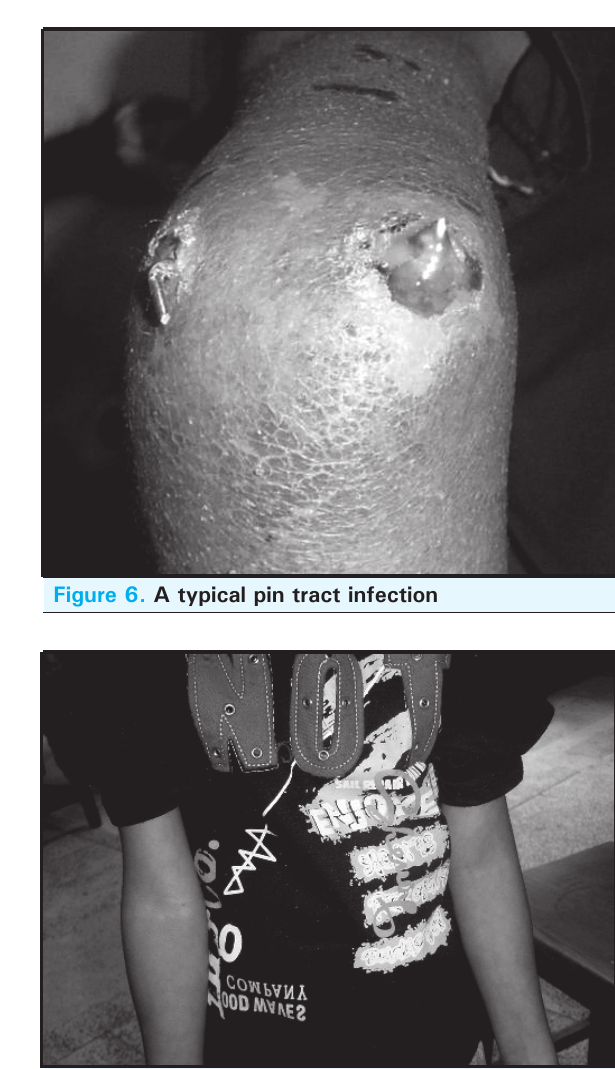
Figure 5. Pre-operative nerve